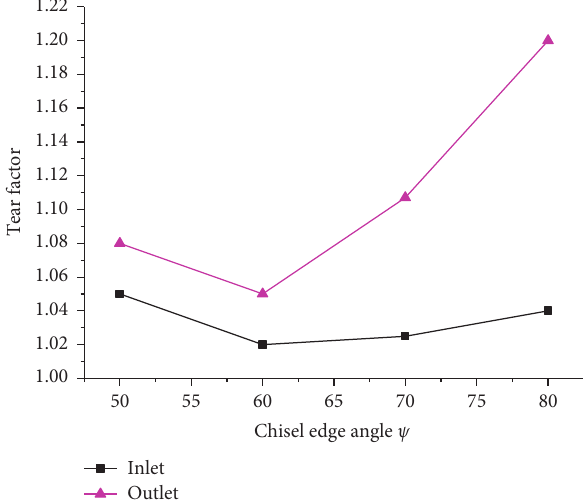
Figure 10: Delamination factor Fd at varying ψ